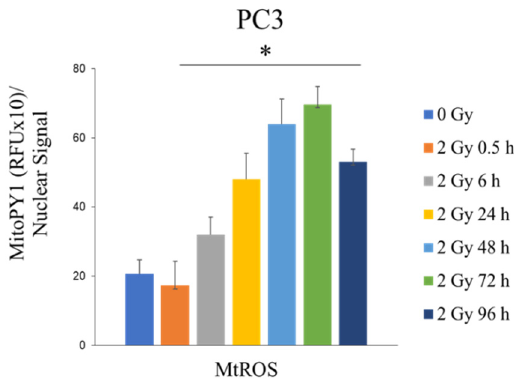
Figure 6. Increase in H 2 O 2 production upon radiation treatment PC3 cells (6 Gy). H 2 O 2 production in mitochondria at 0.5, 6, 24, 48, 72, and 96 h post-RT. * p -value < 0.05 when compared to 0 Gy.